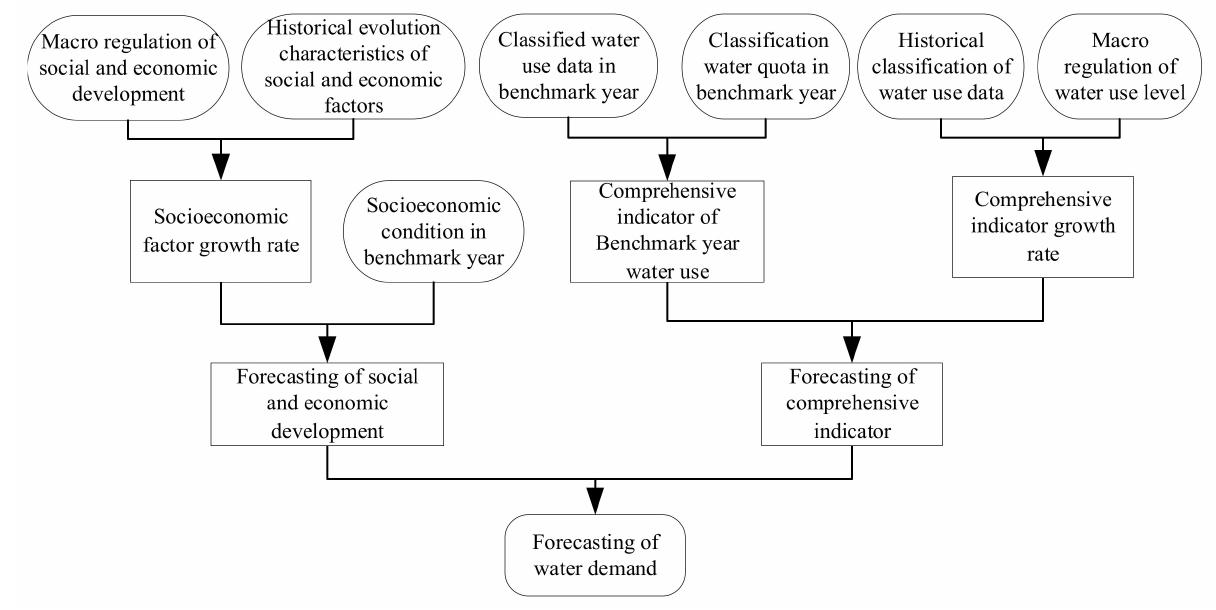
Figure 1. Schematic diagram of water demand forecasting process using classified water index method under macro